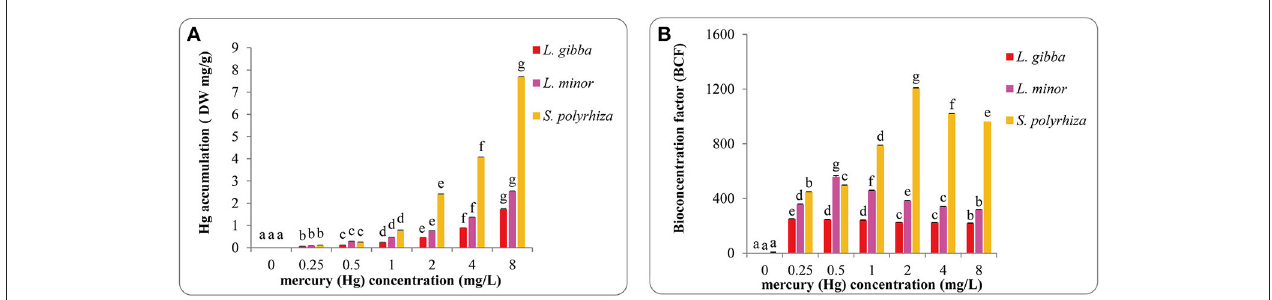
FIGURE 6 | Hg accumulation (A) and bioconcentration factors (BCF) of Hg accumulation (B) of three duckweed lines under different concentrations of Hg treatments. Hg accumulation was measured after 7 days and calculated based on the dry weight (DW).The letters (a, b, c, d, e, f, g) on the column graphs indicated Tukey tests analyses results among different Hg treatments in the same duckweed. The same letters indicated no significant differences and different letters indicated significant difference among treatments. Error bars indicated standard deviation.